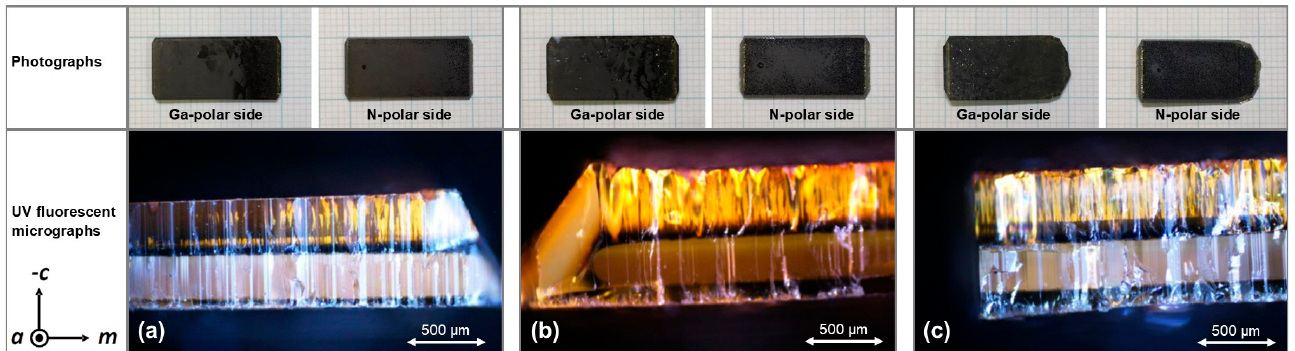
Figure A5. Photographs (top) and UV fluorescent micrographs of cleavage planes (bottom) of crystals grown at ( a ) top, ( b ) middle, and ( c ) bottom position. The lack of optical transparency of the crystals visible in the photographs is related to the cost-effective choice of seeds (HVPE) and nutrient due to the different goals of this study. The UV micrographs were used to quantify seed thickness loss by etch-back as well as effective growth rates stated in Table 8.